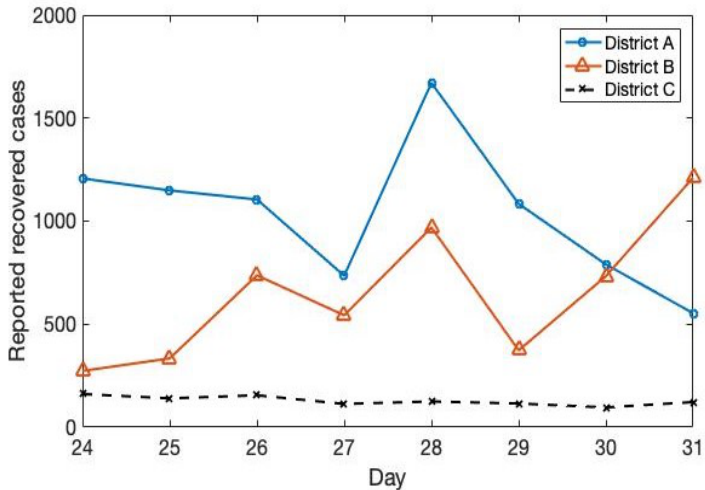
Figure 4. The reported recovered cases during 31 days.